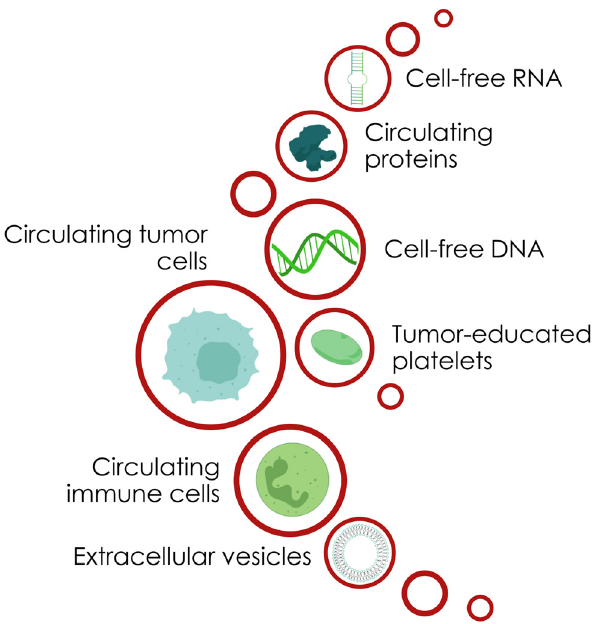
Figure 1: Diversity of liquid biopsy